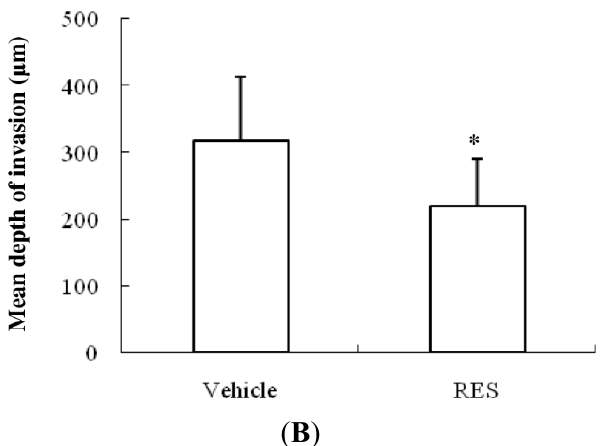
Figure 7. RES reduces invasion of GICs in vivo . 2 × 10 5 GICs (412) in a volume of 5 μL PBS were stereotactically implanted into the brains of mice. Then, the mice were